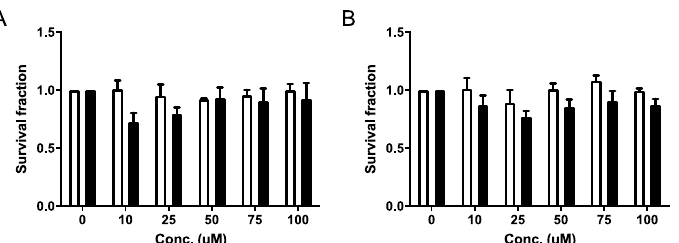
Figure 2. Clonogenic cell survival of ( A ) HT29 and ( B ) HCT116 cells during normoxia (white bars) and anoxia (black bars) when exposed to compound 1b. The data represent the average ± SEM of three independent biological repeats. Table 2. HCR of all compounds IC 50 N vs . IC 50